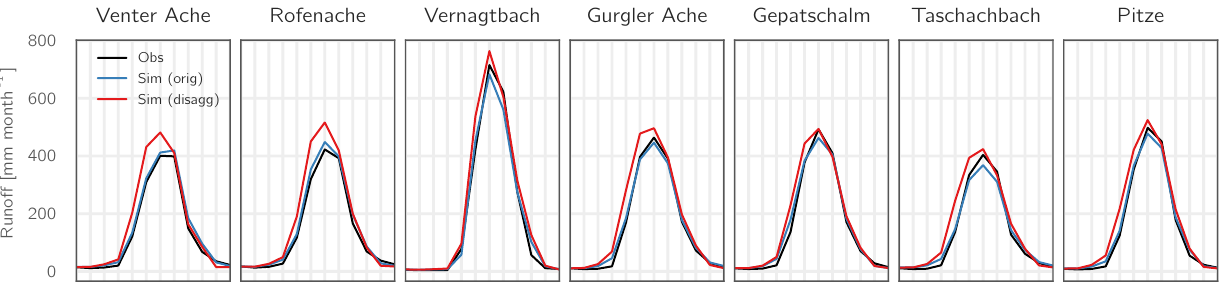
Figure 19. Seasonal cycle of observed (black lines) and simulated monthly runoff for the study catchments and the period 1998–2006. Blue lines correspond to the simulation results for the “reference run” (50m spatial resolution, 1h temporal resolution, original hourly meteorological data as forcing), while the red lines correspond to the simulation run using 100m spatial and 3h temporal resolution as well as disaggregated daily data as forcing.